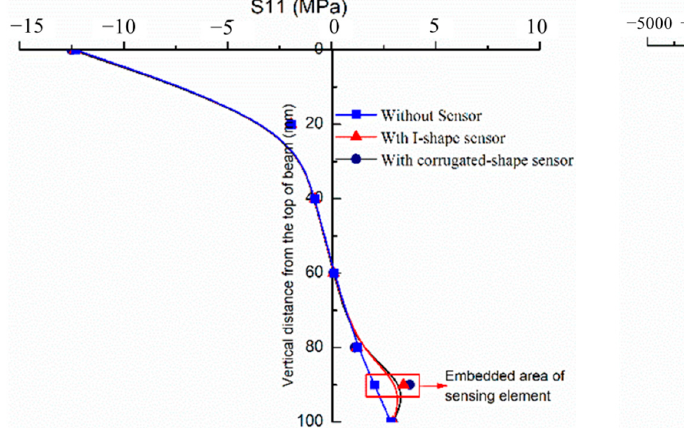
Figure 5. Change in S11 and E11 with the vertical distance from the top of beam, ( a ) S11, ( b ) E11.